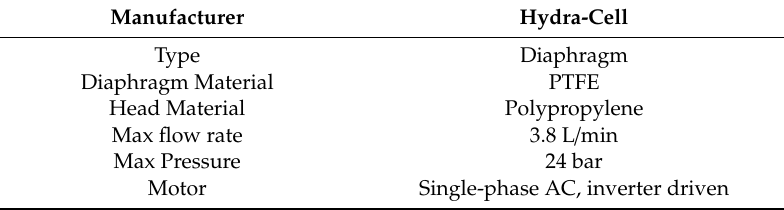
Table 2. Details of the working fluid pump [30].